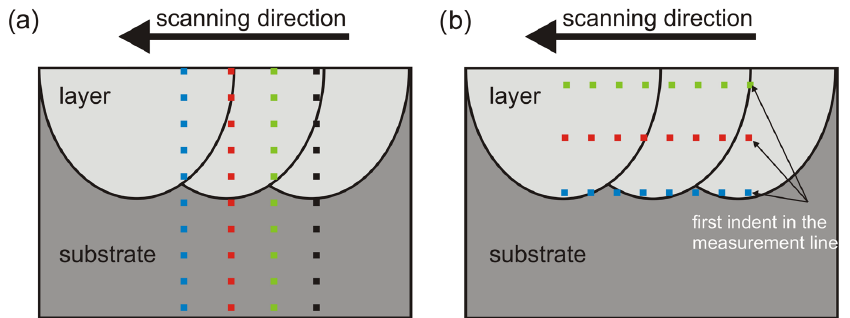
Figure 4. The scheme of the location of measurement points used to prepare microhardness profiles: ( a ) measurements along the straight lines perpendicular to the top surface; ( b ) measurements along the straight lines parallel to the surface.